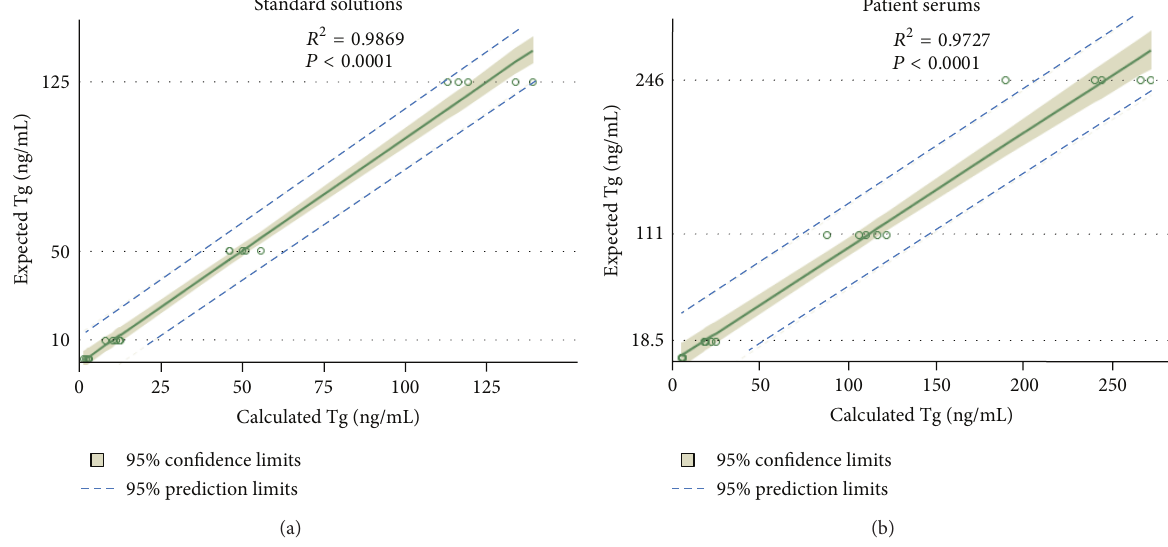
Figure 4: Correlations between the calculated Tg and expected Tg concentrations were found to be excellent in samples produced from both standard solution and patients’